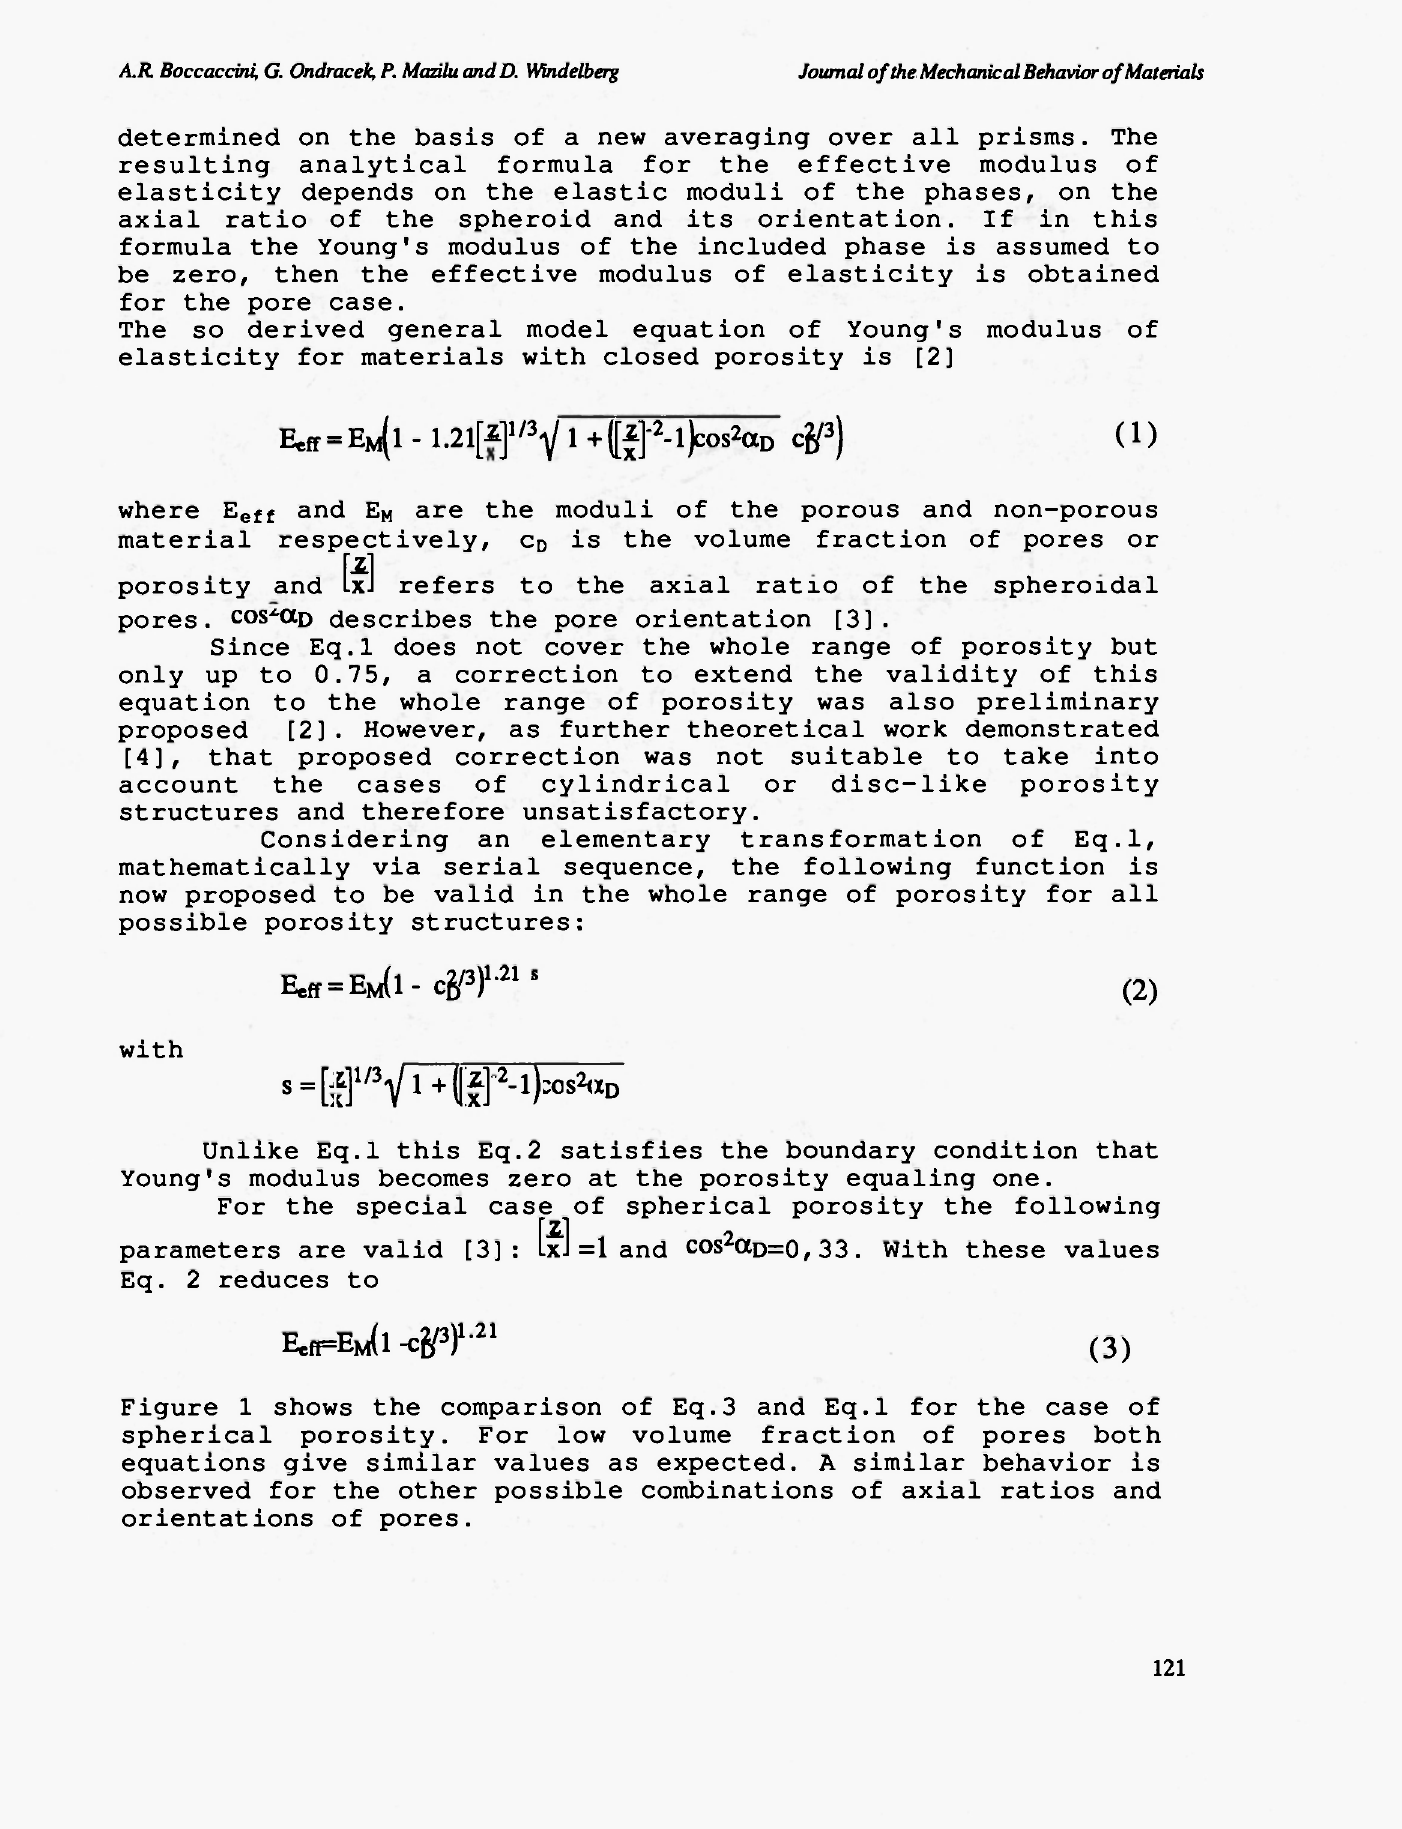
Figure 1 shows the comparison of Eq.3 and Eq.l for the case of spherical porosity. For low of pores both equations give similar values as expected. A similar behavior is observed for the other possible combinations of axial ratios and orientations of